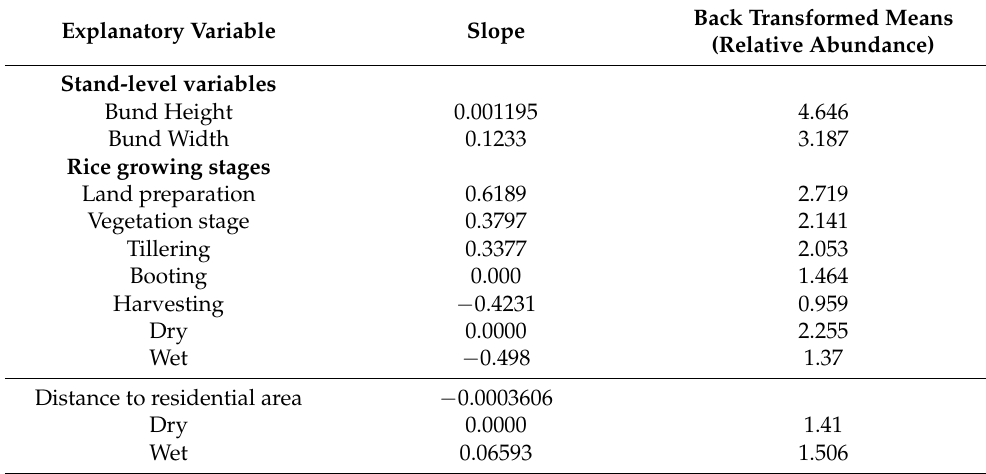
Table 5. Slopes and back-transformed means for explanatory stand- and landscape-level variables determining variables’ influence to relative rodent